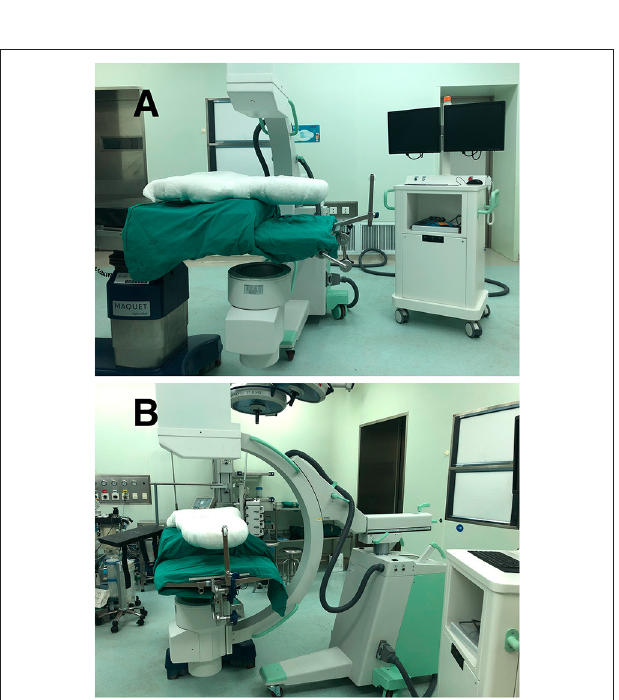
FIGURE 2 | The BSPST system and C-arm digital radiography machine from different positions (A,B) , which can make anterior-posterior interoperative radiography